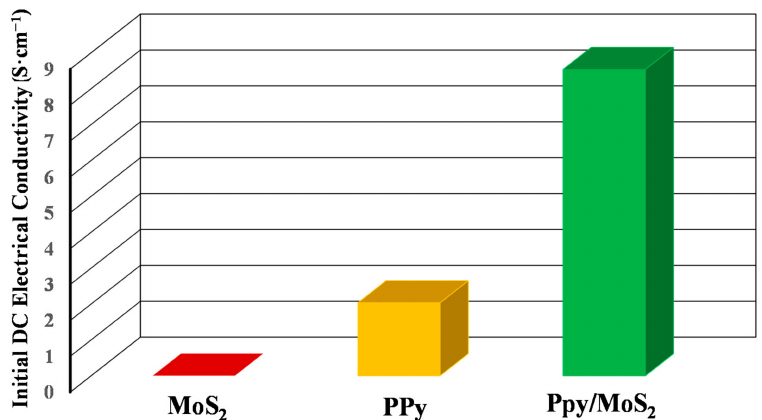
Figure 5. Initial DC electrical conductivities of MoS 2 , PPy and PPy / MoS 2 nanocomposites.